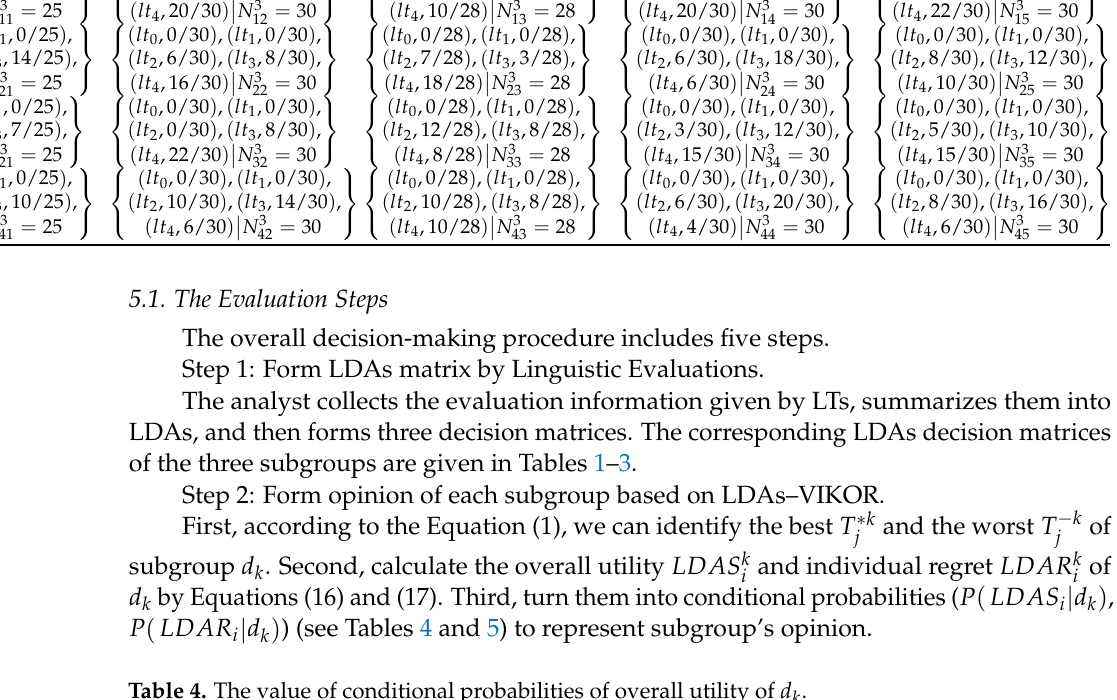
Table 4. The value of conditional probabilities of overall utility of d k .